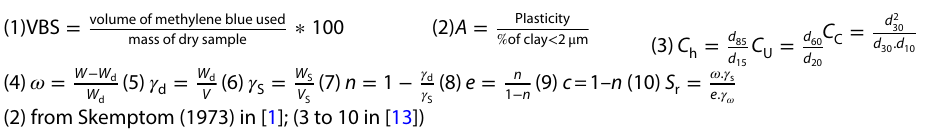
volumeofmethyleneblueused